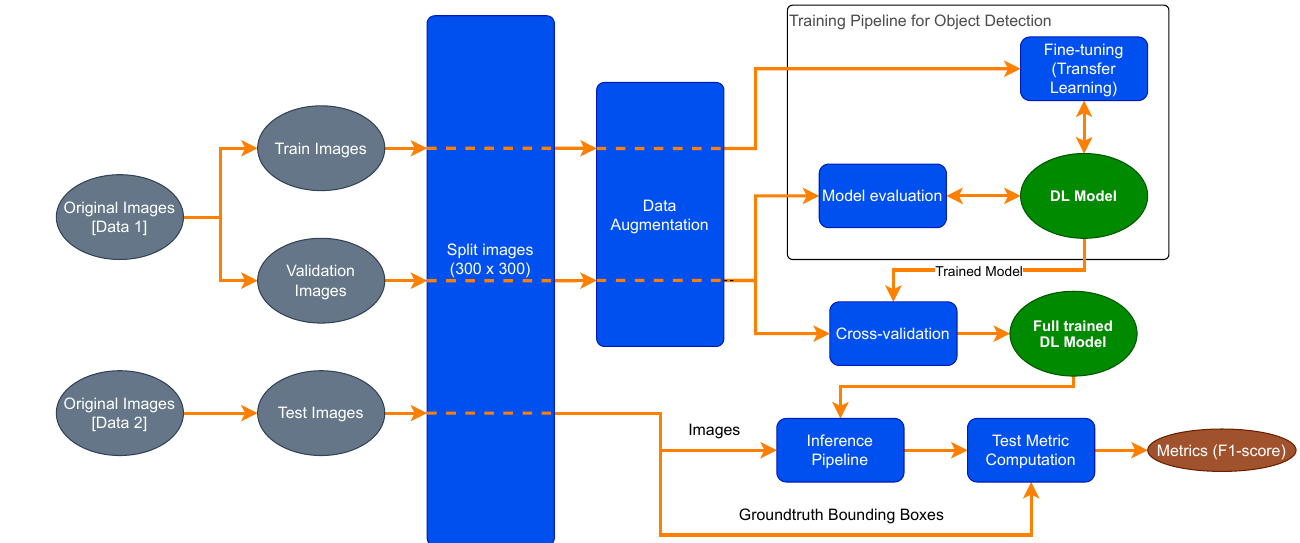
Figure 4. Overview of the performed methods. Training and evaluation